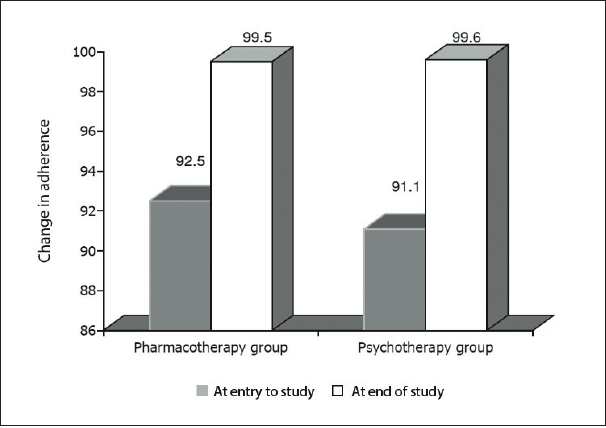
Fig. 2. Changes in ART adherence in the antidepressant v. IPT groups.